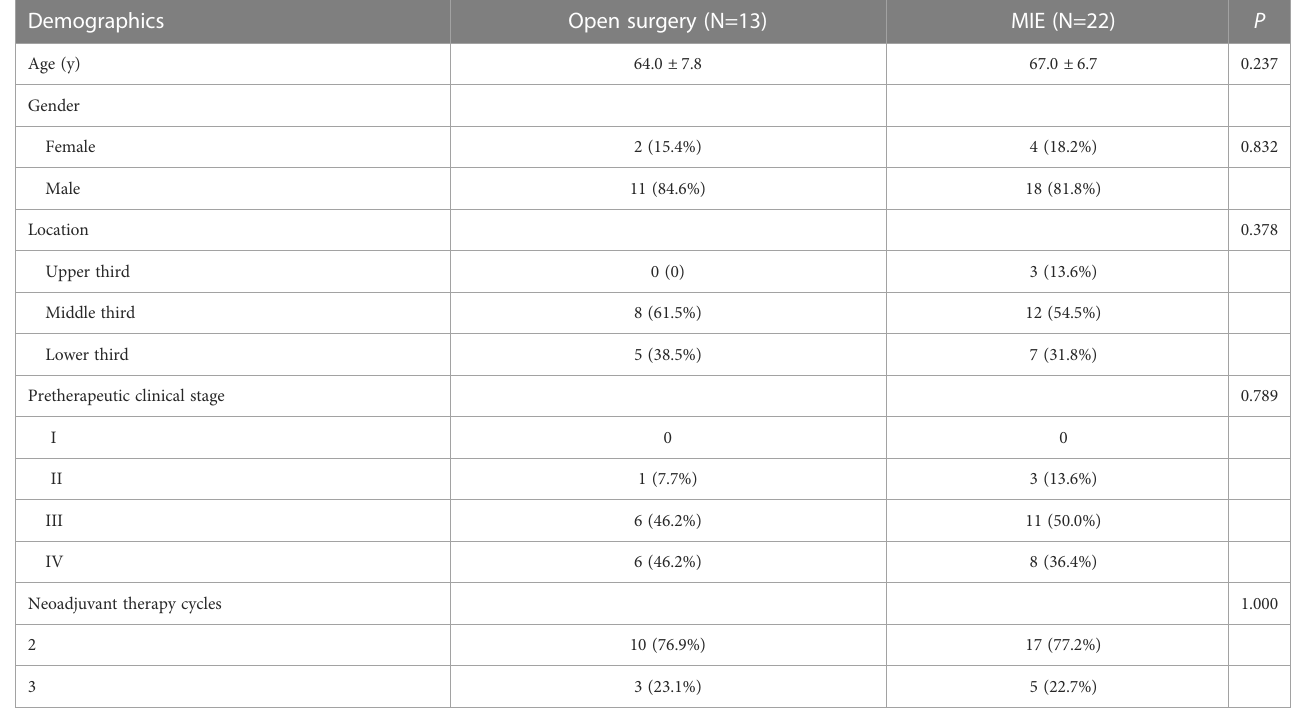
TABLE 1 Baseline characteristics of patients strati fi ed by the surgical approach.